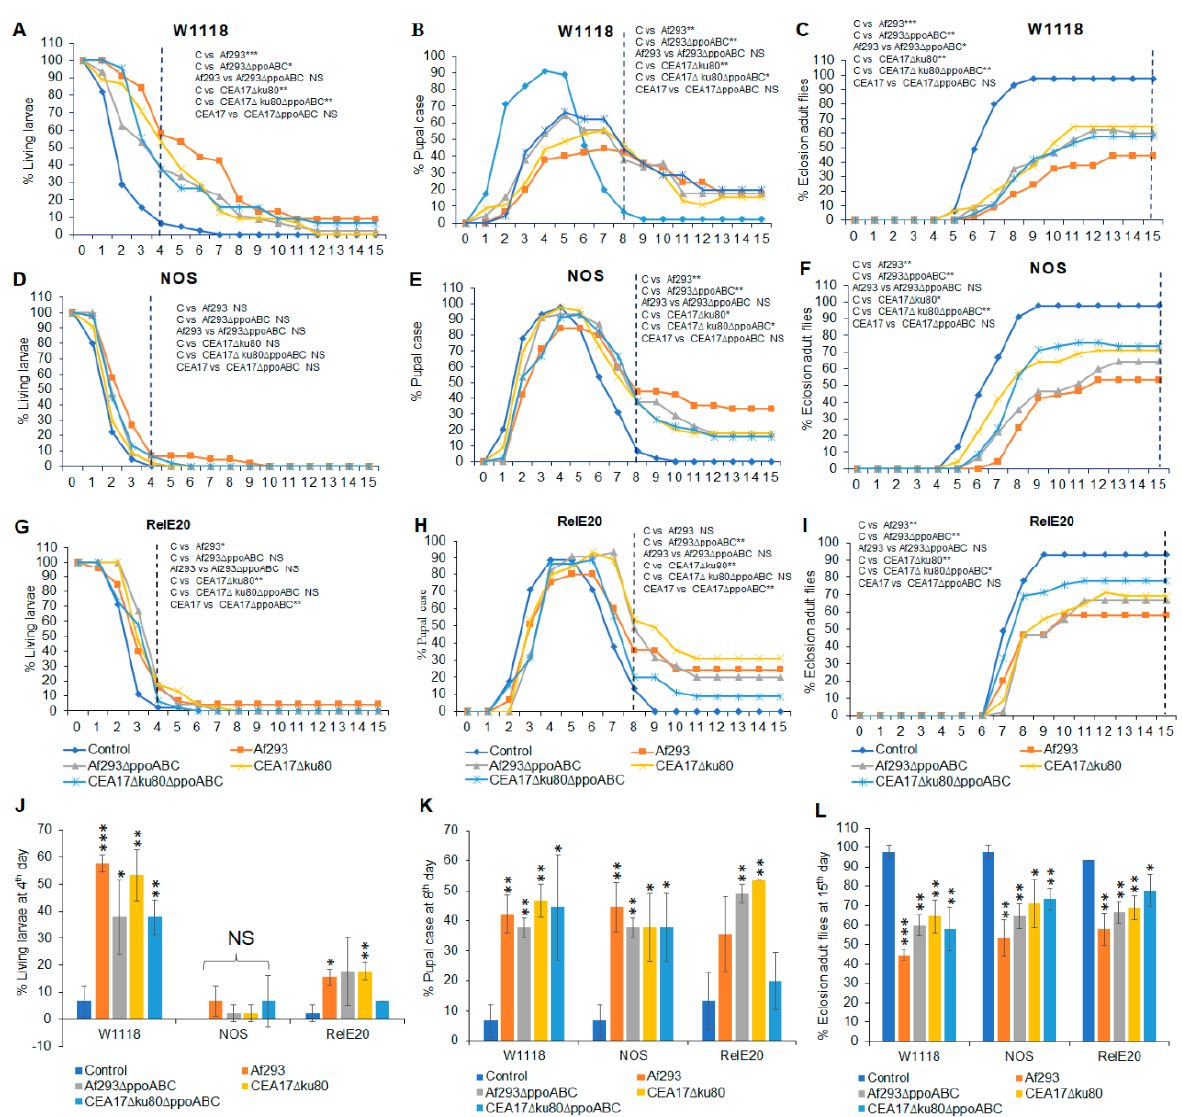
Figure 2. Effects of VOCs emitted from four different A . fumigatus strains pre − grown on PDA Figure 2. E ff ects of VOCs emi tt ed from four di ff erent A . fumigatus strains pre − grown on PDA at 37 °C for 3 days on the third instar white − eyed fl y larvae over 15 days of continuous exposure. The percentages of living larvae, pupal case, and eclosion adult fl ies are as follows: w 1118 living larvae ( A ), NOS larvae ( D ), and Rel E20 larvae ( G ); w 1118 pupal case ( B ), NOS pupal case ( E ), and Rel E20 pupal case ( H ); and w 1118 eclosion adult fl ies ( C ), NOS eclosion adult fl ies ( F ), and Rel E20 eclosion adult fl ies ( I ). The statistical analyses were performed for the living larvae on the 4th day ( J ), the pupal case on the 8th day ( K ), and the eclosion adult fl ies on the 15th day ( L ). A dashed vertical line denotes the days for statistical analysis (N = 180). * Represents the signi fi cant di ff erences between di ff erent treat- ments, where 0.005 < * p < 0.05, 0.0005 < ** p < 0.005, *** p < 0.0005; NS, p > 0.05.